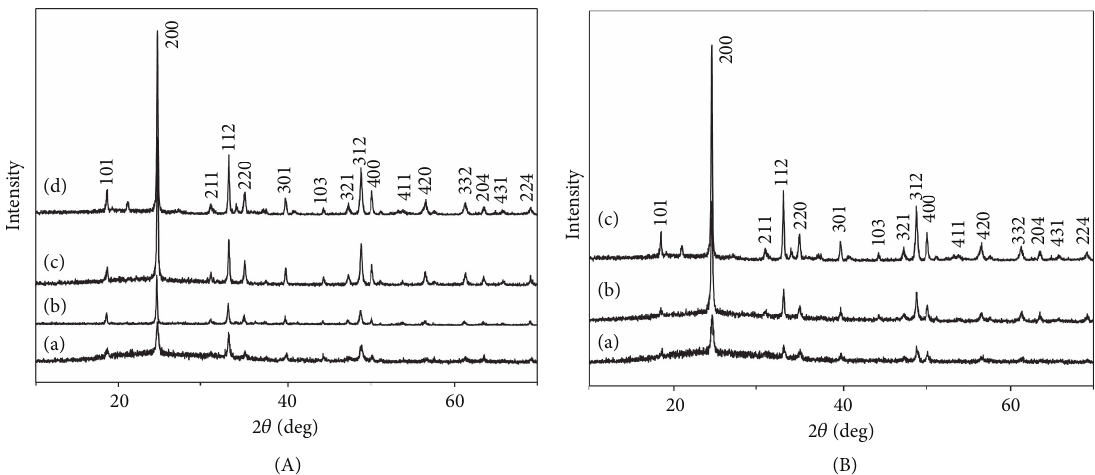
Figure 1: X-ray diffraction patterns of SmVO 4 nanocrystals obtained (A) under 180 ∘ C, with different pH values: (a) EDTA, pH = 4; (b) EDTA, pH = 6; (c) EDTA, pH = 8; (d) EDTA, pH = 10, and (B) under pH = 10, with different temperatures: (a) EDTA, 140 ∘ C; (b) EDTA, 160 ∘ C; (c) EDTA, 180 ∘ C.